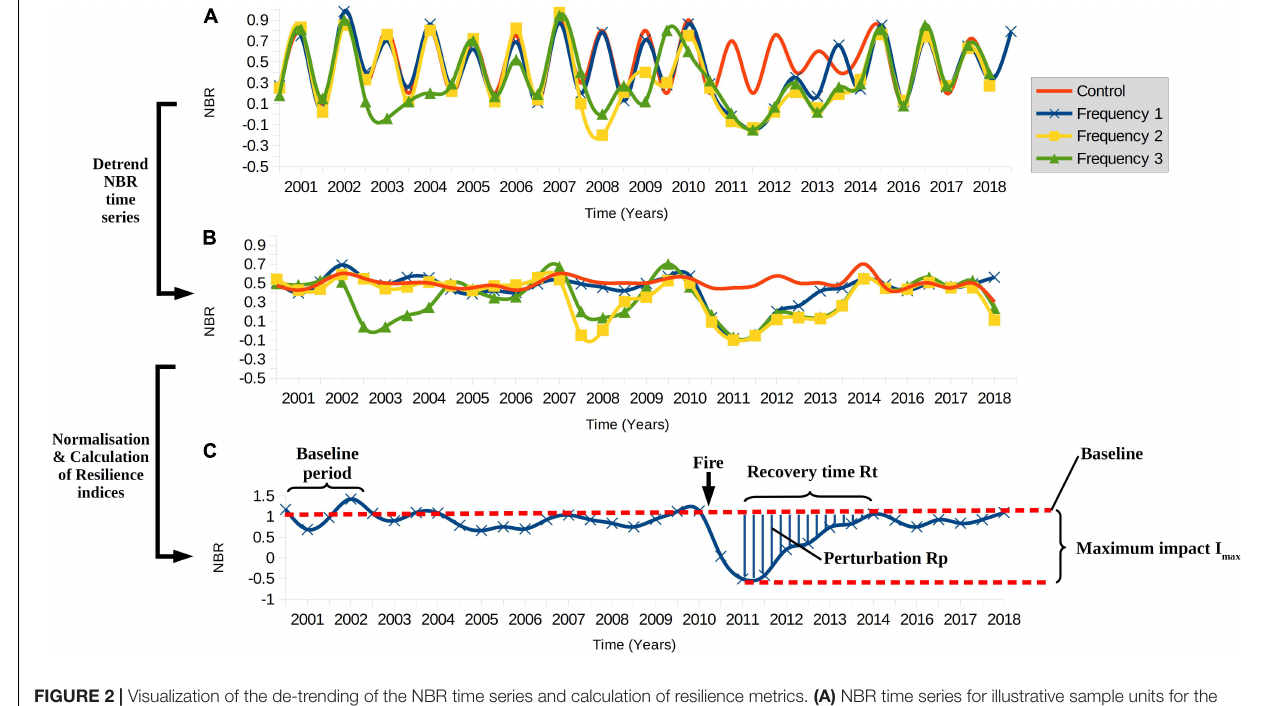
FIGURE 2 | Visualization of the de-trending of the NBR time series and calculation of resilience metrics. (A) NBR time series for illustrative sample units for the different fire frequencies considered in this study. The drops in NBR in the years 2002, 2007, and 2010 represent the fire effects. In each case, the final fire occurs in 2010. (B) The example NBR time series from a. after seasonal de-trending using Fourier filtering. In (A,B) , each fire frequency is shown in a different color and line style, defined by the legend at the top right. (C) The seasonally de-trended and base-normalized NBR time series with important values for the quantification of resilience highlighted. For clarity, only the Fire Frequency 1 time series are shown. The following terms are defined: Fire: the date at which fire occurs; Baseline: the pre-fire NBR baseline, derived by averaging NBR values pre-2002; Rp: the post-fire perturbation, indicated by the shaded area between the NBR curve and the baseline between the time point when NBR is lowest and when the baseline is reached again; I max : the maximum percentage loss in NBR shortly after fire, relative to the baseline. Rt: the amount of time it takes from the lowest NBR value after fire until the baseline is reached again. Together, Rt, I max and Rp quantify